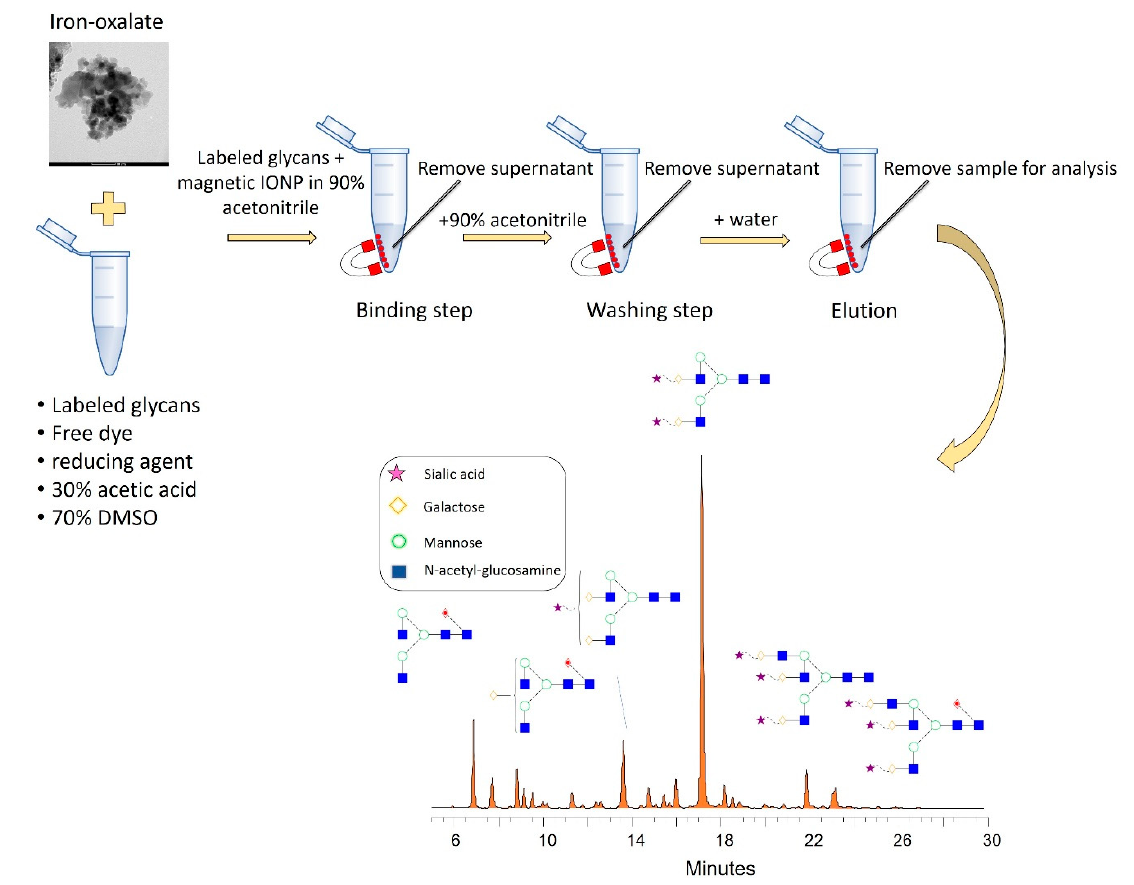
Figure 2. Flow-chart of the magnetic nanoparticle-based sample clean-up.